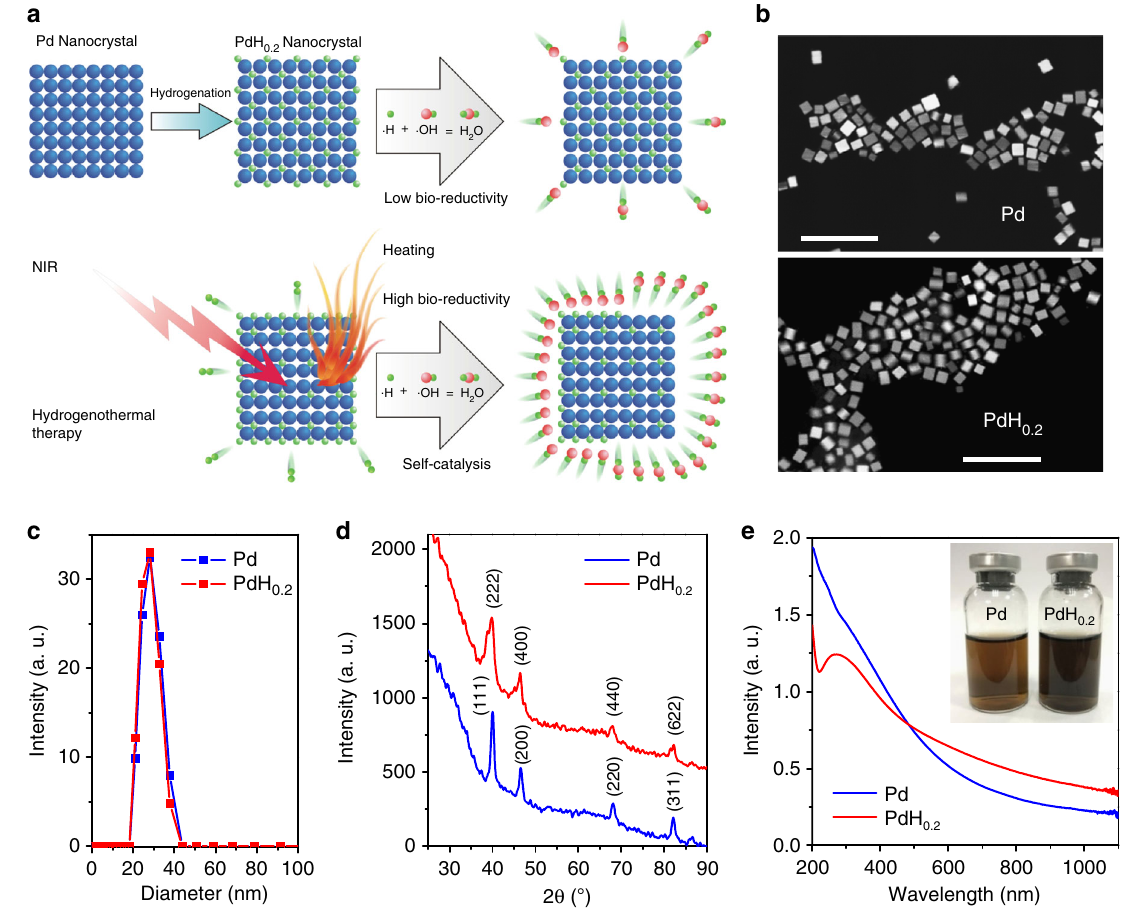
Fig. 1 Synthesis and characterization of PdH 0.2 nanocrystals. a Schematic illustration of the synthesis and NIR-controlled release of bio-reductive hydrogen and the generated heat from PdH 0.2 nanocrystals for hydrogenothermal therapy. b SEM images of Pd and PdH 0.2 nanocrystals. Scale bar, 100 nm. c DLS data of Pd and PdH 0.2 nanocrystals. d XRD patterns of Pd and PdH 0.2 nanocrystals. e UV − VIS − NIR spectra of Pd and PdH 0.2 nanocrystals (60 μ g mL − 1